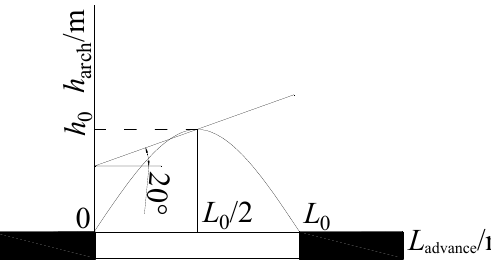
Figure 17. Curve track of force chain arch.